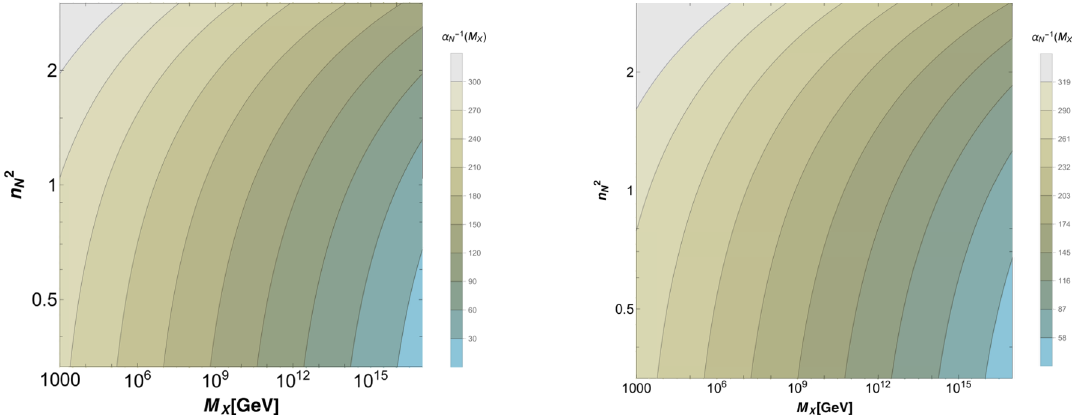
contours in the U(1) N plane, for a benchmark choice M X = 10 M 8 X